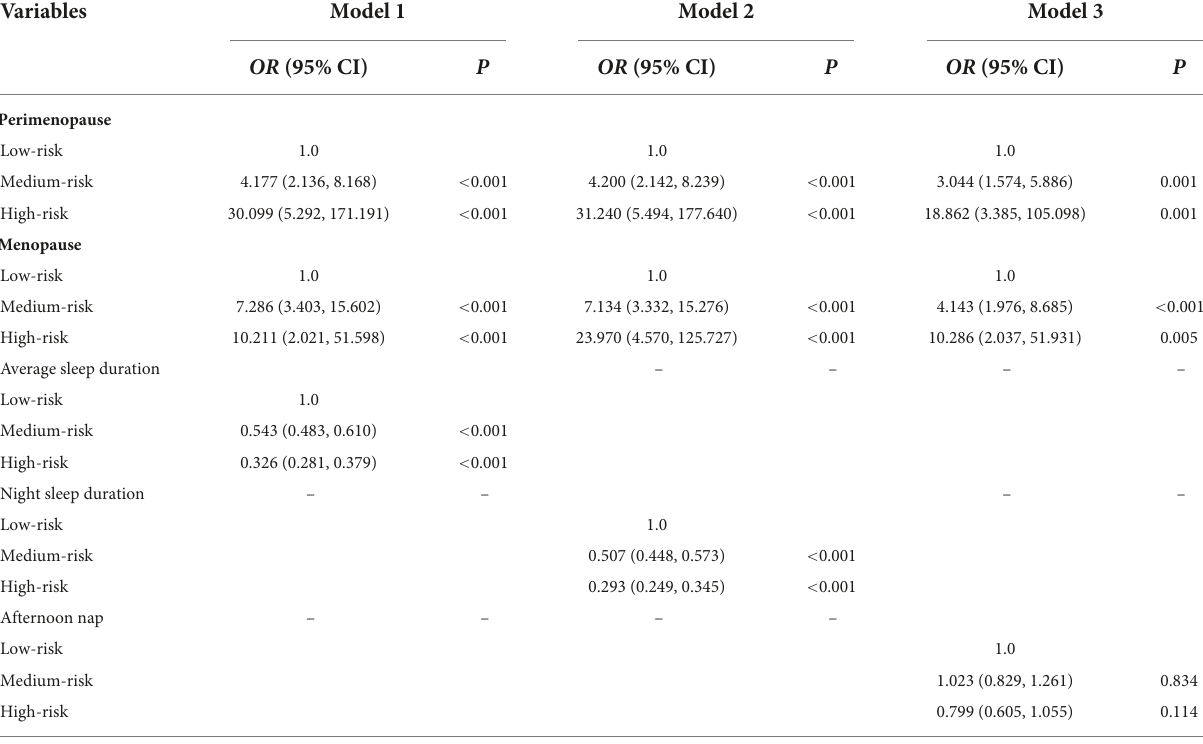
TABLE 2 Multivariate regression analysis on the relationships between perimenopause, menopause, sleep duration and stroke risk. Variables Model 1 Model 2 Model